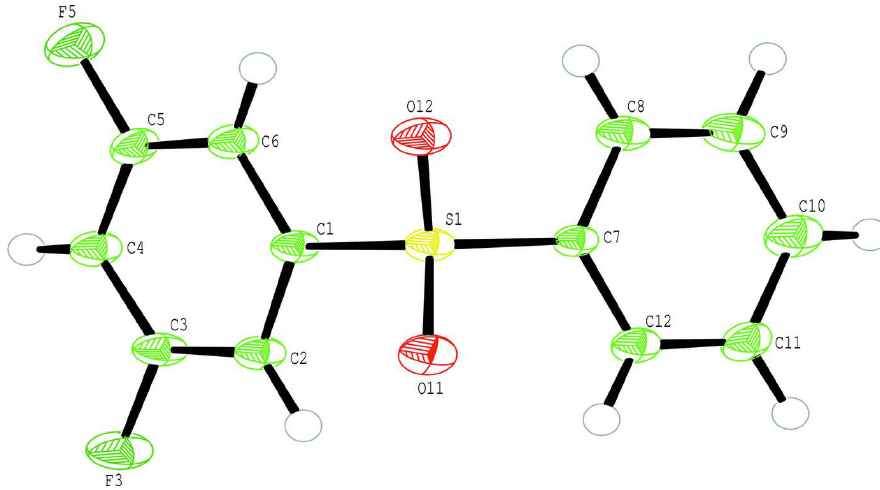
Figure 1 The molecular structure of (I) showing 50% displacement ellipsoids for the non-hydrogen atoms. 3,5-Difluorophenyl phenyl sulfone Crystal